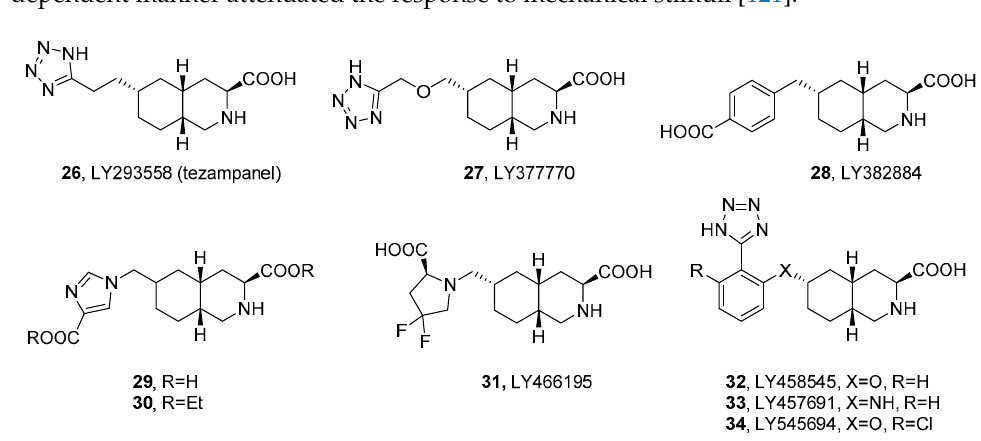
Figure 5. Structures of c is -decahydroisoquinoline-derived KAR antagonists.